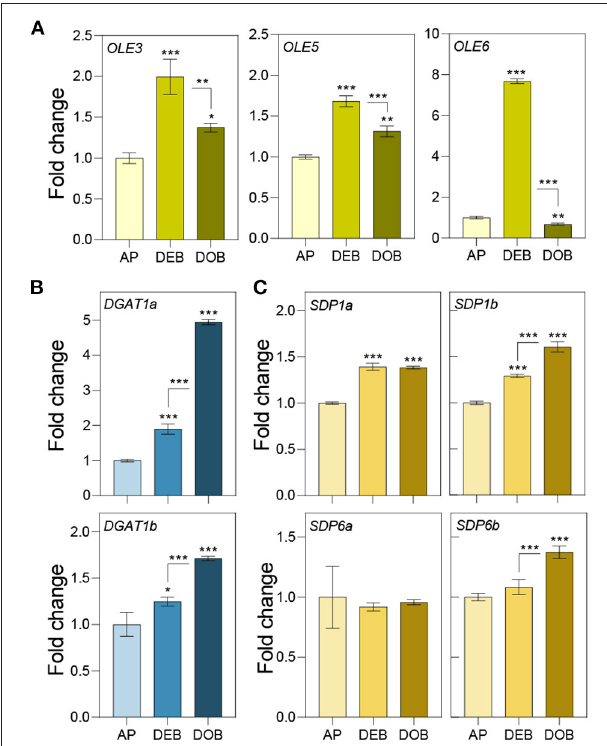
FIGURE 2 | Expression of genes involved in lipid body production and lipid turnover. Relative expression of (A) OLEOSIN genes (OLE3 , OLE5 , and OLE6) , (B) lipid biosynthesis genes ( DGAT1a,b ), and (C) lipase genes ( SDP1a and b, and SDP6a and b ) in apices under long day (APs), and in developing buds (DEBs), and dormant buds (DOBs) in short days. Values are calculated relative to the control (AP) and represent the means of three technical replicates ± SD of four plants. Asterisk(s) indicate statistical significance between treatments (one-way ANOVA, Tukey analysis; * P < 0.05; ** P < 0.01; and *** P <